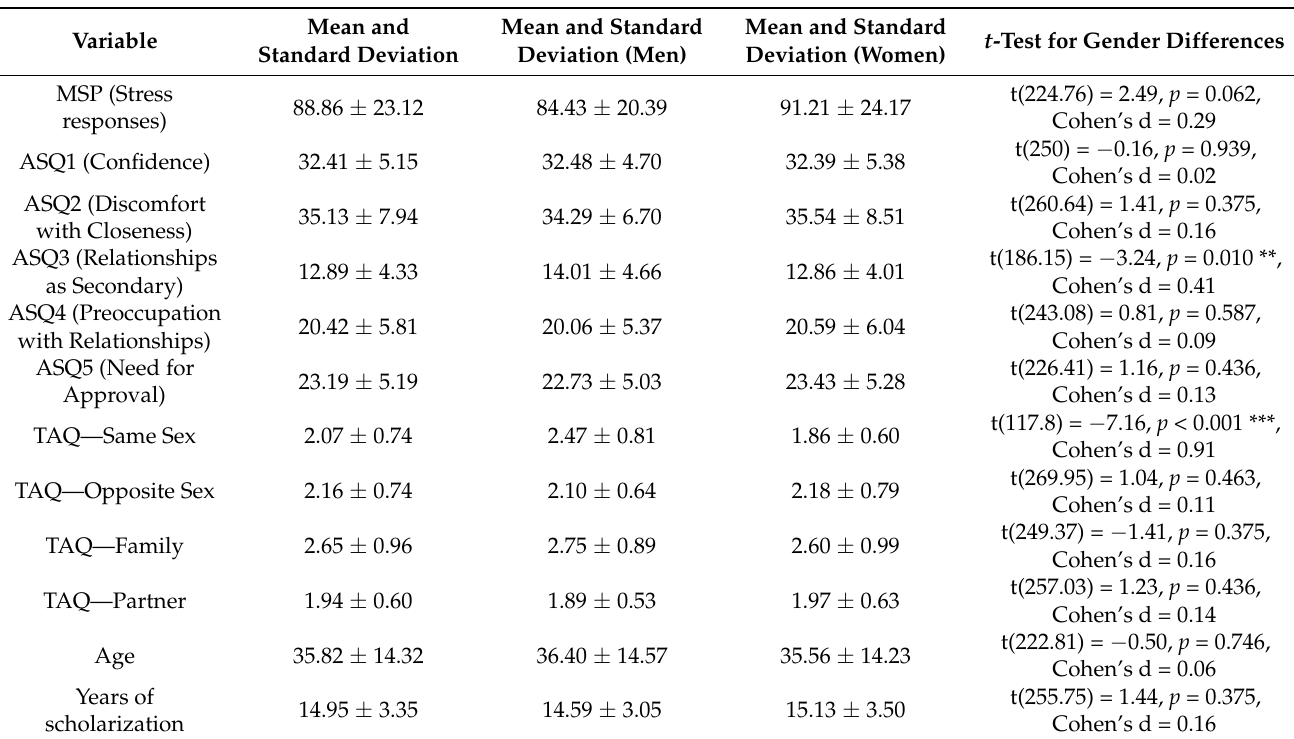
Table 1. Descriptive statistics for measured variables and t -tests for gender differences. ** = significant for p < 0.01; *** =